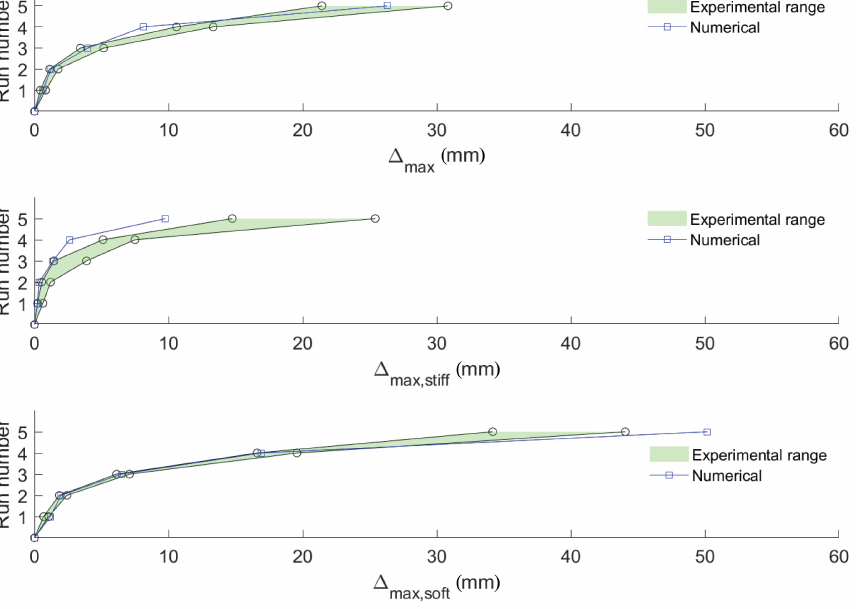
Figure 10. Comparison of experimental and numerical maximum displacements at each